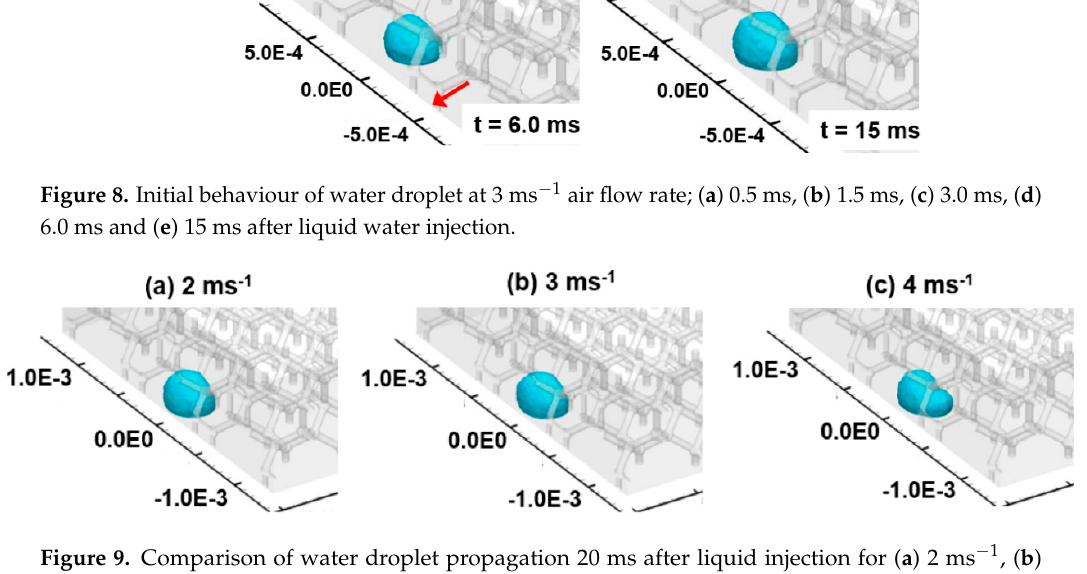
Figure 9. Comparison of water droplet propagation 20 ms after liquid injection for ( a ) 2 ms − 1 , ( b ) 3 ms − 1 and ( c ) 4 ms − 1 air flow condition.